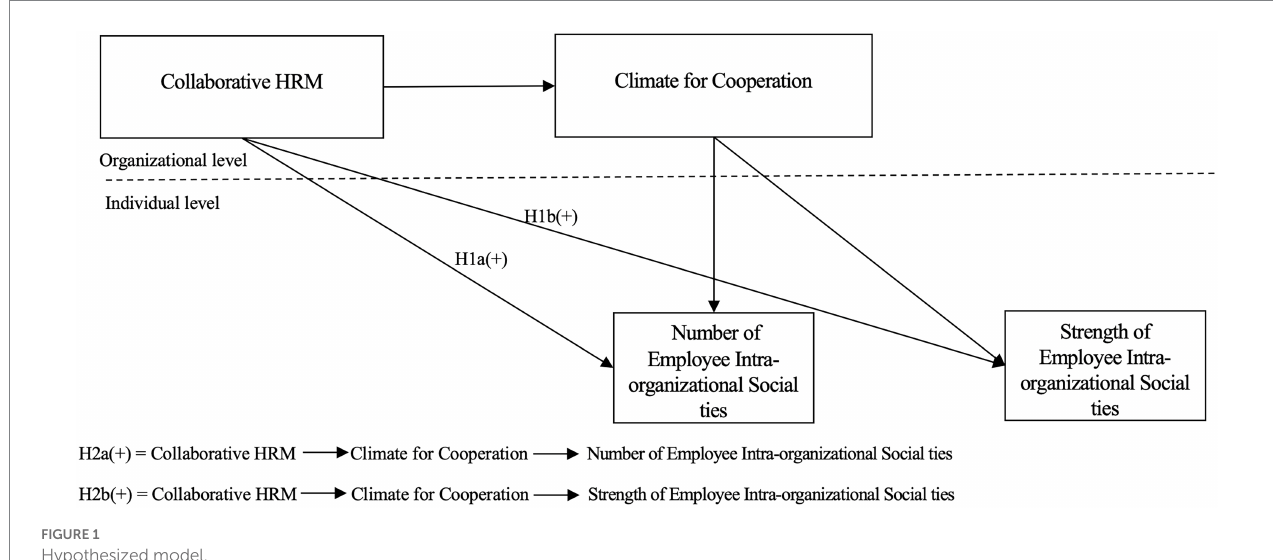
FIGURE 1 Hypothesized